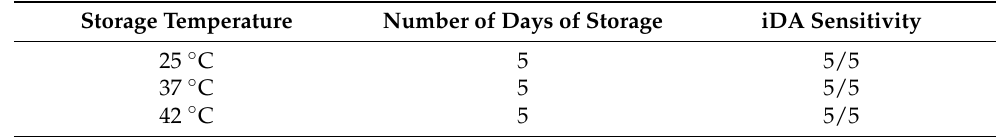
Table 4. Effect of long-term incubation of buccal swabs at variable temperatures on iDA